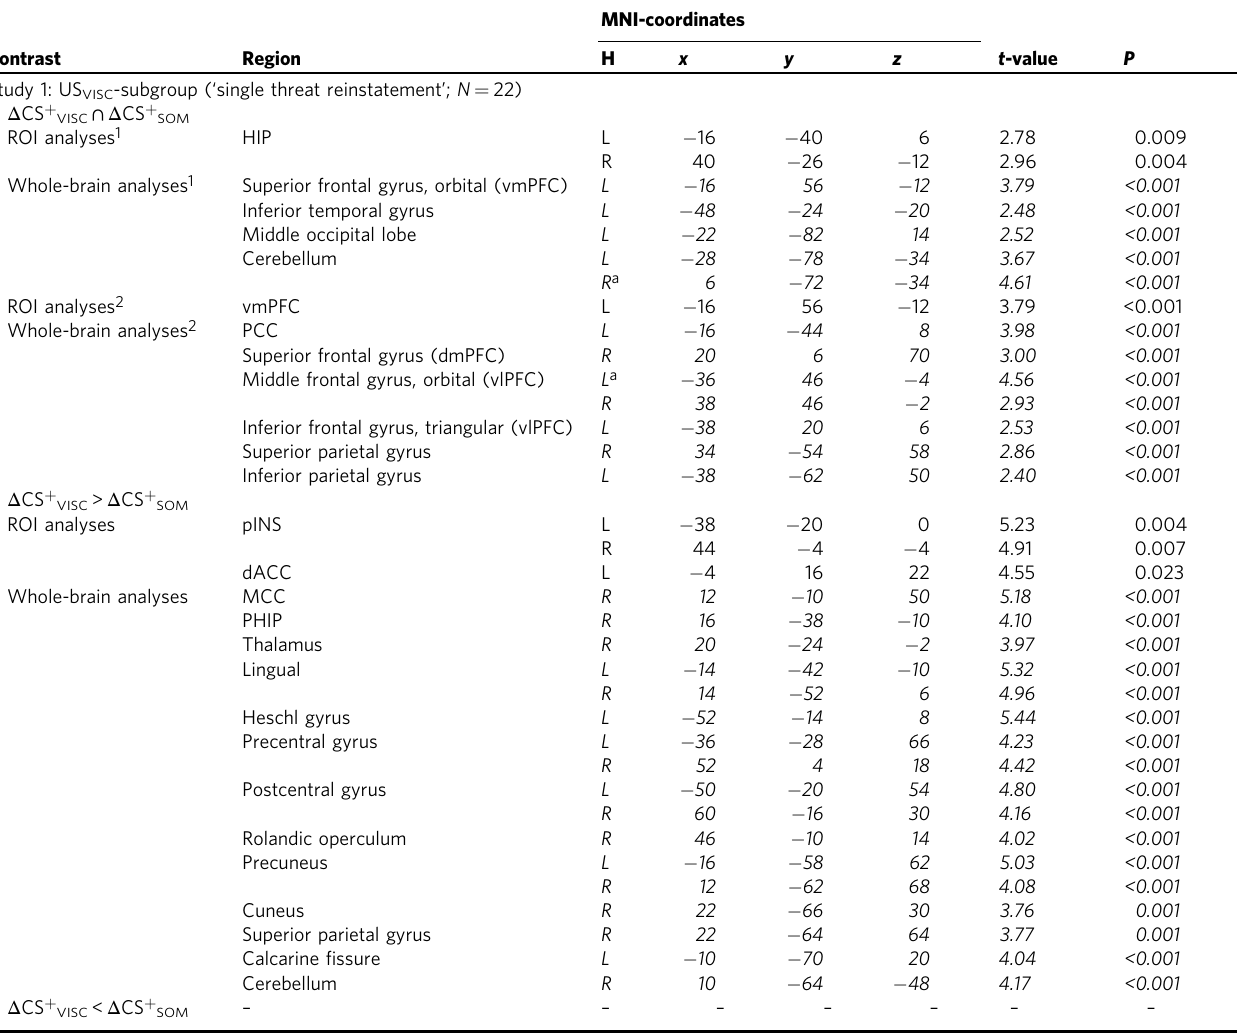
Table 4 Neural activation induced by cues (CS) predicting interoceptive versus exteroceptive threats during reinstatement-test after visceral single threat reinstatement in study